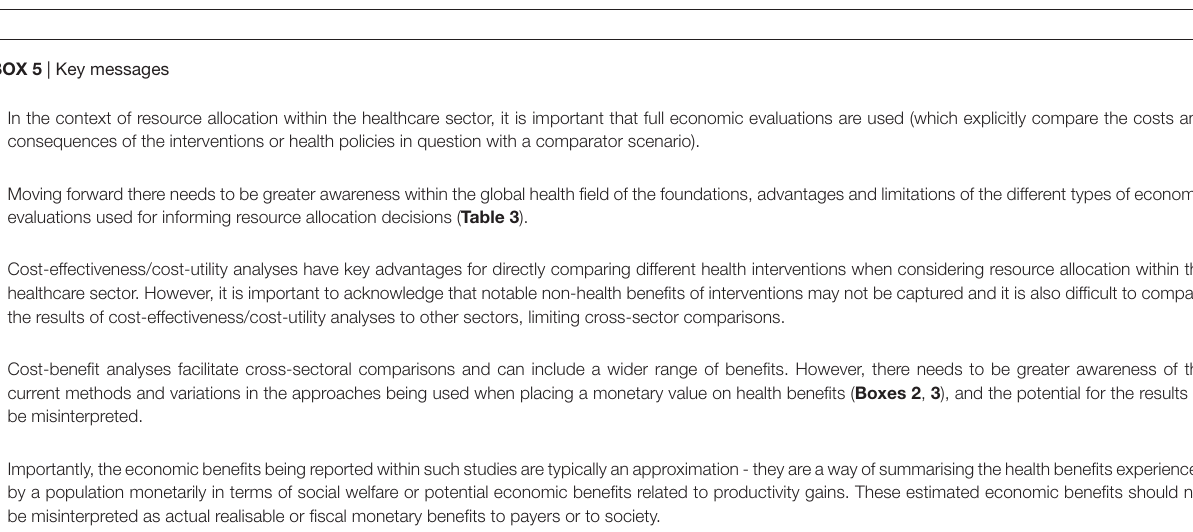
FIGURE 5 | A hypothetical example showing the potential difference between the human capital approach or the friction cost approach when estimating productivity costs. Costs are being discounted at 3% per